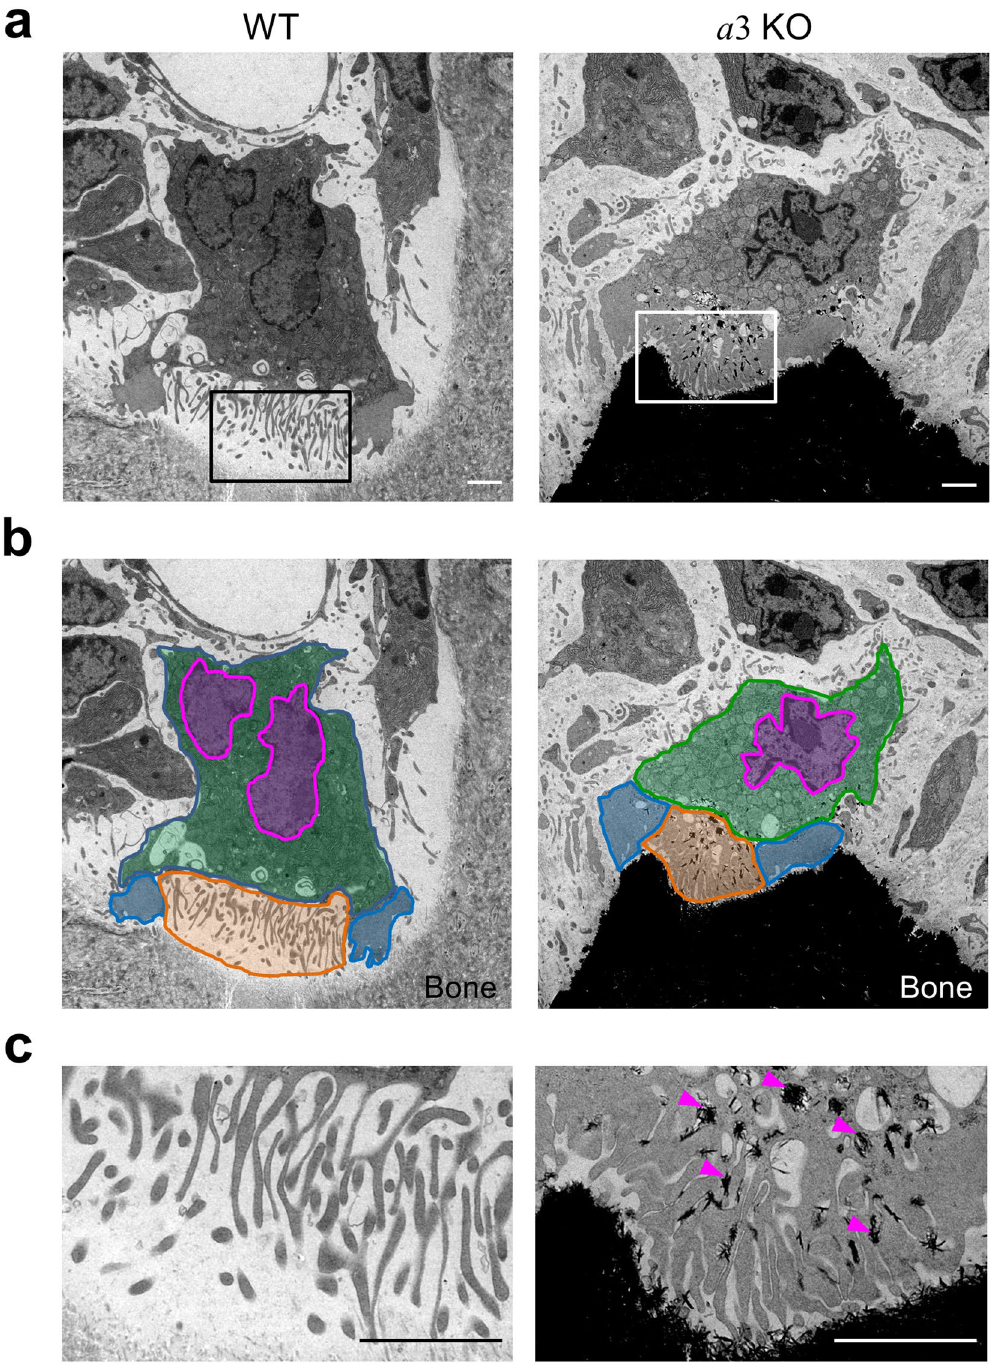
Figure 1. Osteoclasts in the epiphysis of humeral bones from wild-type and a 3-knockout mice. Electron micrographs of a representative area containing osteoclasts in the humeral epiphysis from wild-type ( a , WT) and a 3-knockout ( a , a 3KO) mice are shown, together with coloured images ( b ). The ruffled border (orange), actin rings (blue), nucleus (magenta) and cytoplasm (green) are indicated schematically. An osteoclast faces the bone matrix with a finger-like ruffled border between the peripheral clear zone (actin ring). Higher magnification images of the boxed area in a are shown in c . In the mutant mouse, electron-dense material is found between processes of the ruffled border ( c , arrowheads). The bone matrix is markedly more electron- opaque in the mutant mouse than in the wild-type mouse. The images are representative of 18 wild-type cells and 14 a 3-knockout cells. Bars indicate 2 μ